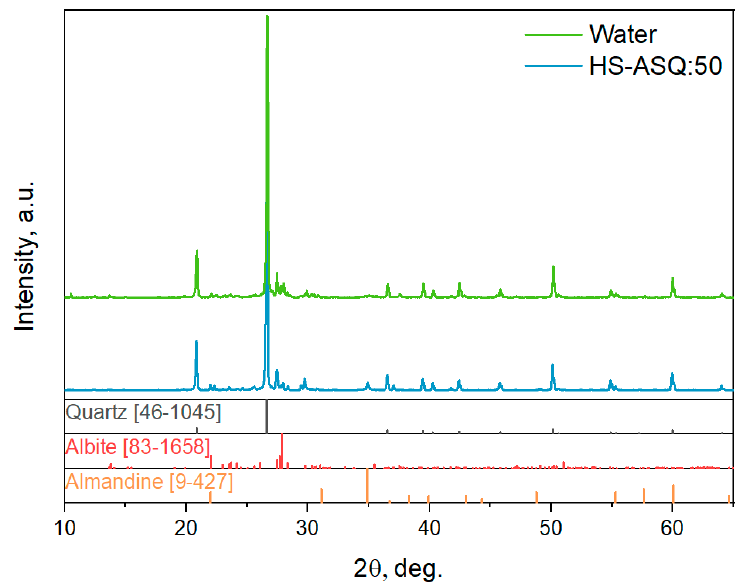
Figure 8. PXRD patterns of dust particles treated with water and with HS–ASQ:50.